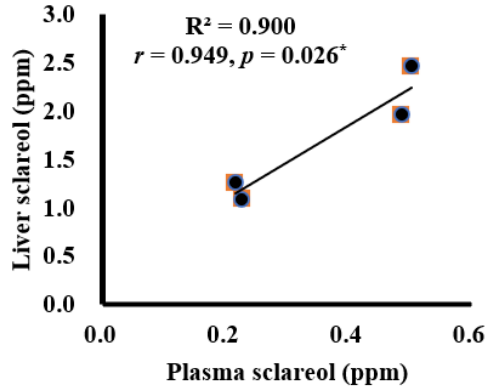
Figure 4. Correlation between plasma and liver homogenate sclareol concentrations 30 min after transdermal administration of sclareol ( n = 4). There was a strong positive correlation between the plasma sclareol concentration and liver sclareol concentration ( r = 0.949, p = 0.026). The correlation between these parameters was analyzed using Pearson’s correlation analysis with the SPSS 24.0 statistical software package. * p < 0.05.